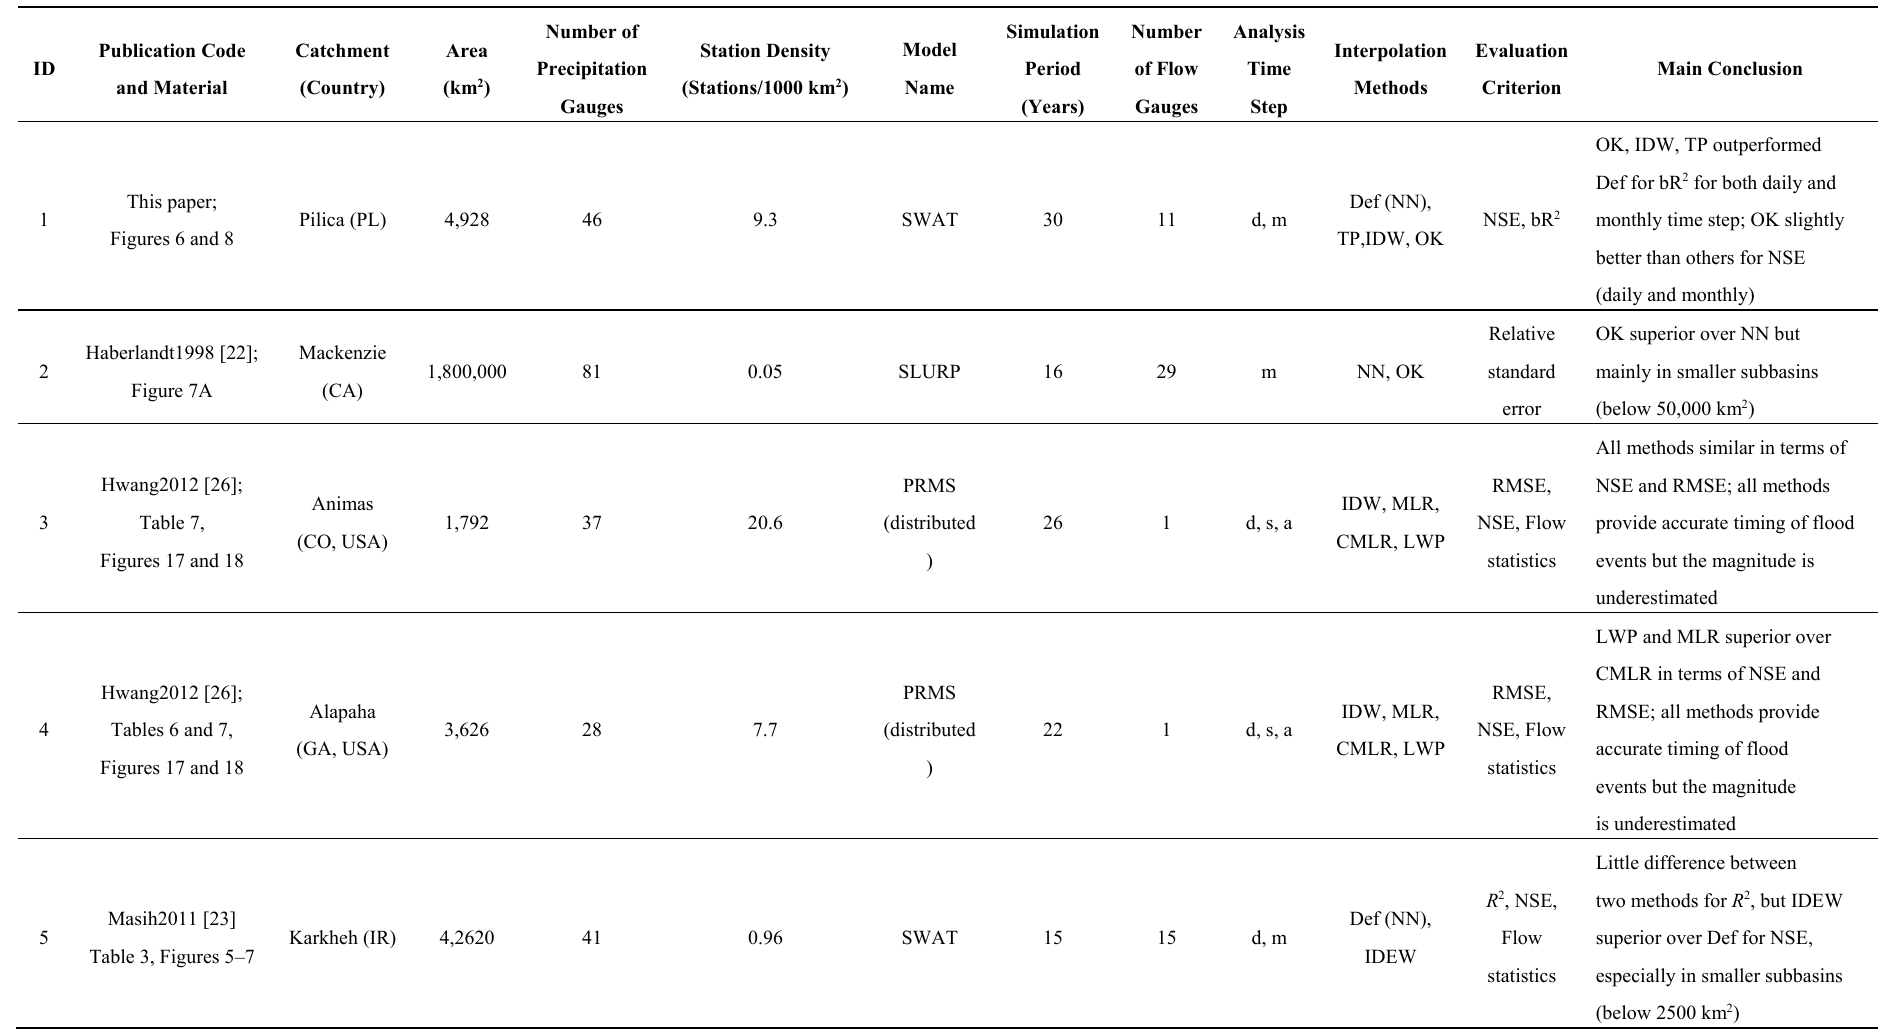
Table 4. Literature review of studies evaluating precipitation interpolation methods for hydrological